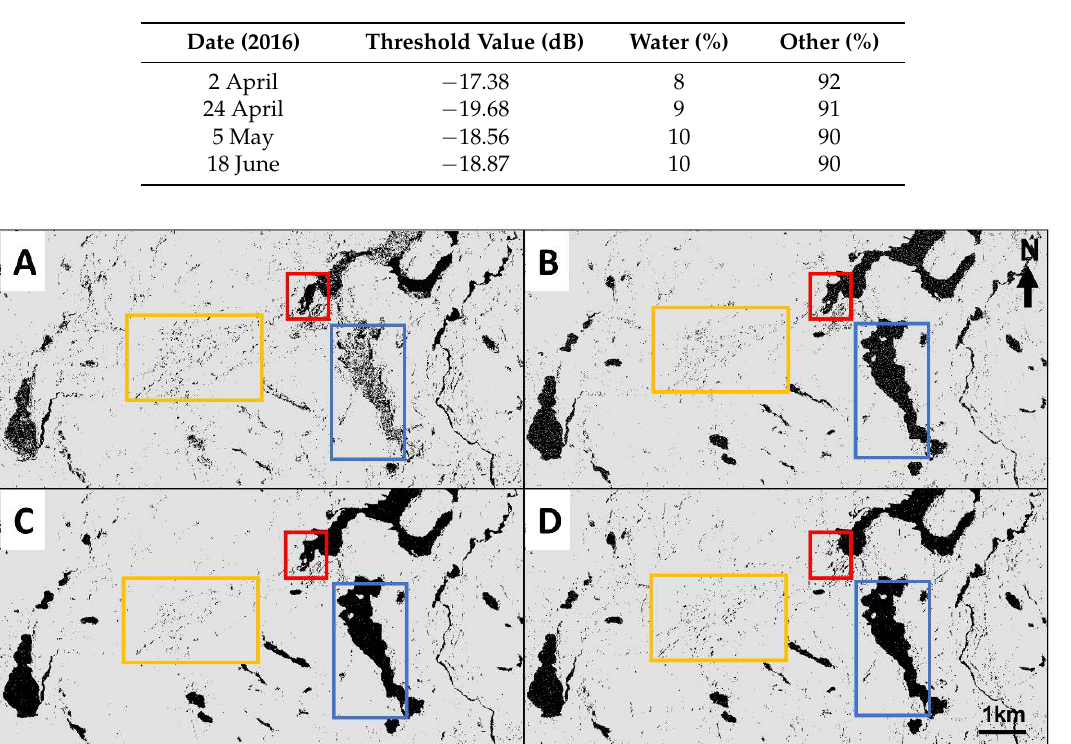
Table 2. Percentages of each class and threshold values used in each TerraSAR-X (TSX) scene using grey-level thresholding.